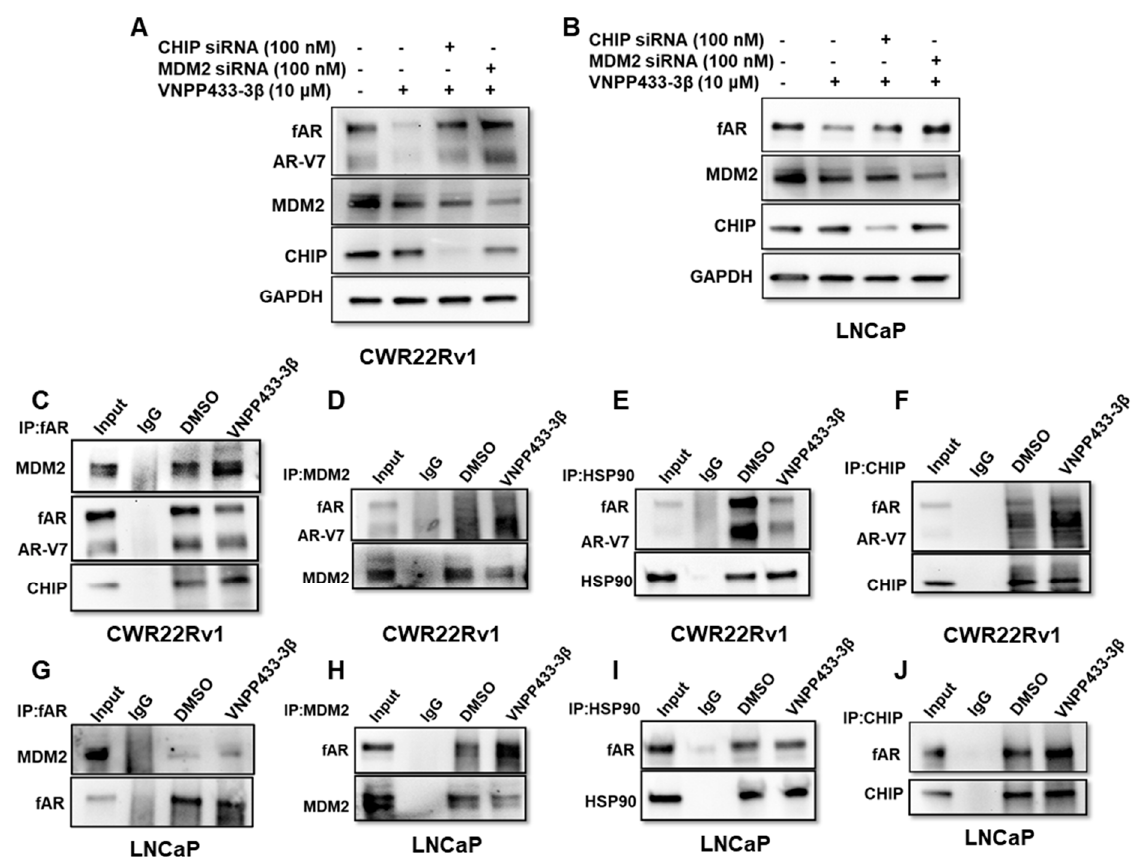
Figure 4. VNPP433-3 β triggers AR/AR-V7 degradation by promoting enhanced interaction of fAR with E3 ligases MDM2 and CHIP. ( A ) CWR22Rv1 and ( B ) LNCaP cells were transfected with siRNA of MDM2 or CHIP (100 nM, Ambion) for 48 h and exposed to VNPP433-3 β (10 μ M) for 24 h and the lysates were immunoblotted for AR, MDM2, CHIP, and GAPDH. Scrambled siRNA served as control. CWR22Rv1 ( C – F ) and LNCaP ( G – J ) cells were hormone-starved for 48 h and treated with DMSO or VNPP433-3 β for 4 h. Cell lysate containing 1 mg protein was subjected to immunoprecip- itation and subsequent immunoblotting for AR, MDM2, HSP90, and CHIP.